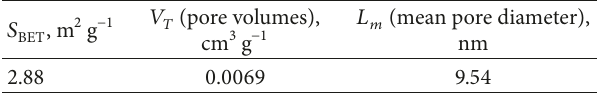
Table 1: Porous characteristics of the obtained hybrid polymer. 2 g 𝑆 BET , m